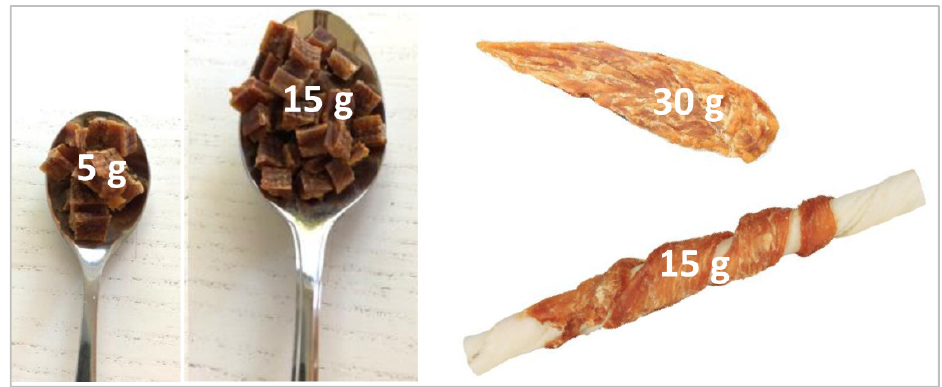
Figure 1. Quantification of jerky treats. Conversions applied for the amount of jerky ingested by the dogs as stated by the owner in a questionnaire for owners of dogs suspected of jerky induced Fanconi syndrome.